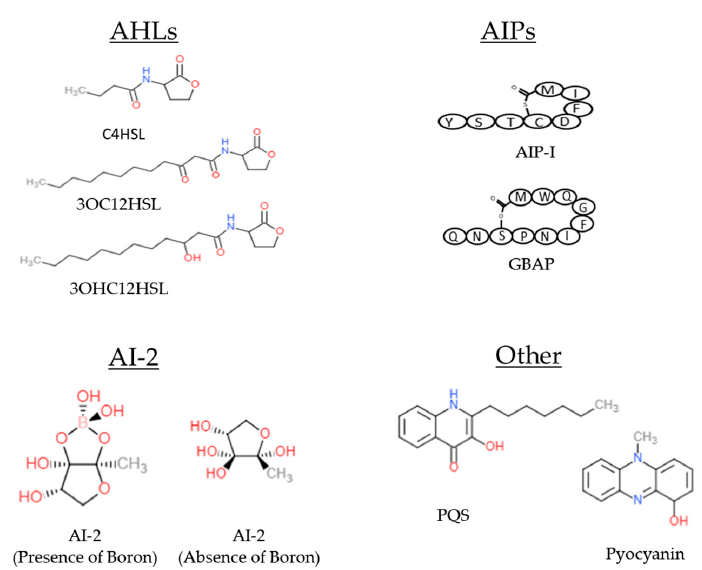
Figure 1. Chemical structure of common autoinducers discussed in this review.